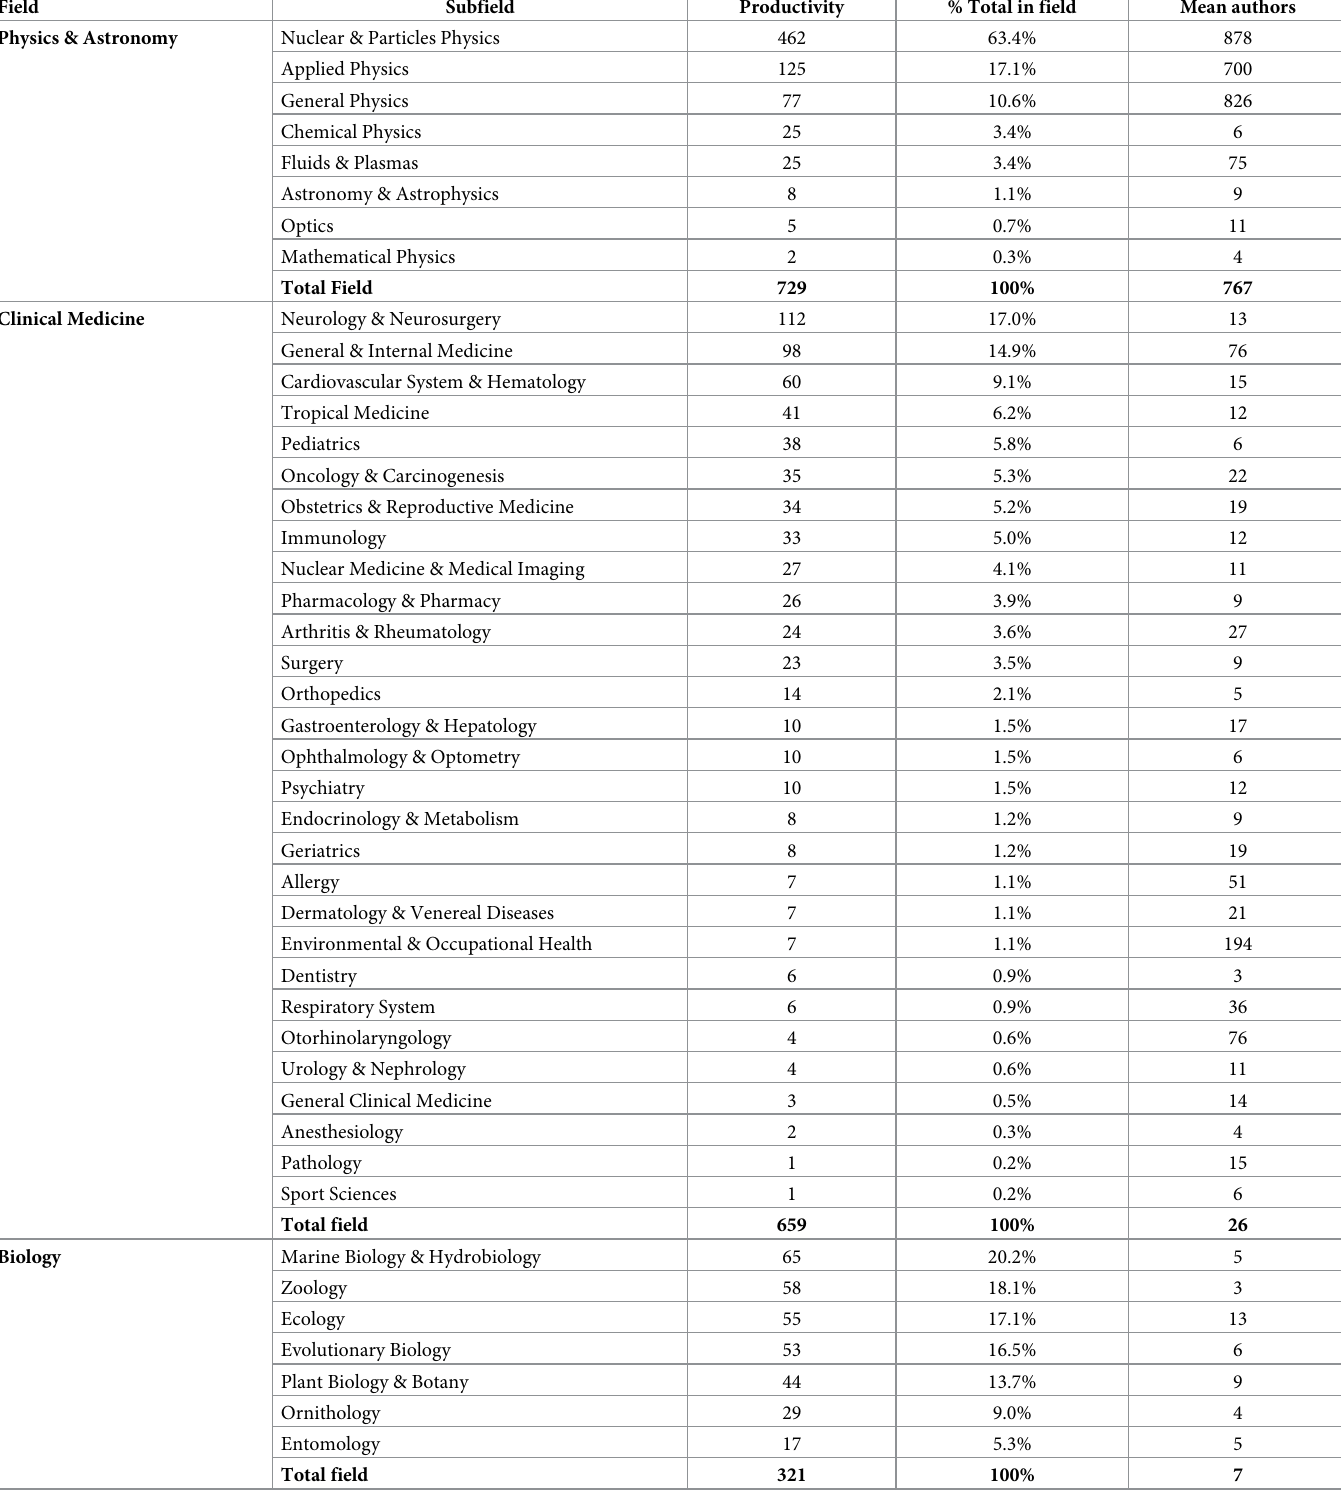
Table 2. Cuban scientific output in collaboration with the U.S. according to the subfield of research January 1, 1980-December 31, 2020.